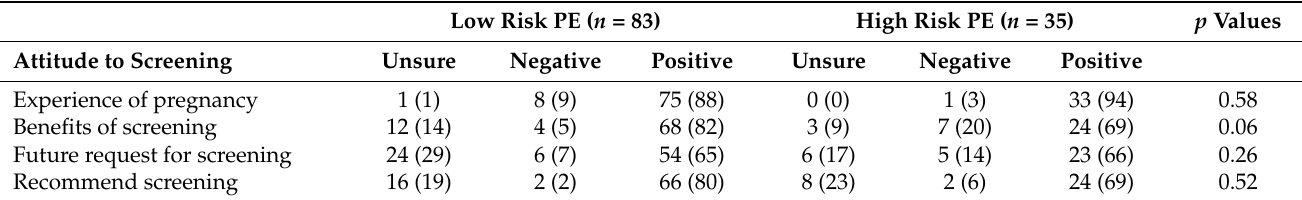
Table 4. Group (low and high PE risk) differences in attitude toward PE screening at time